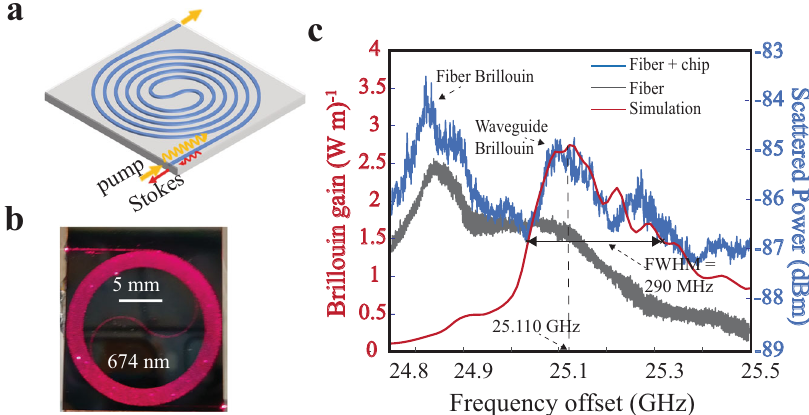
Fig. 2 Waveguide design and 674 nm spontaneous Brillouin measurement. a Two meter single mode waveguide spiral used for the spontaneous Brillouin gain measurement. b Photograph of the actual 2 meter spiral shown while illuminated with 674nm light. 5 mm scale is shown for reference. c Measured and simulated spontaneous Brillouin gain with 25.110 GHz fi rst order Stokes (S1) frequency shift, 2.73 (W m) − 1 gain peak, and 290 MHz bandwidth. The resolution bandwidth (RBW) of electrical spectrum analyzer (ESA) was set at 100 Hz. The measured blue curve shows the Brillouin contribution from both the fi ber and silicon nitride waveguide, while the gray trace shows contribution from only the fi ber, which con fi rms that the peak at 25.110 GHz is due to waveguide spontaneous Brillouin